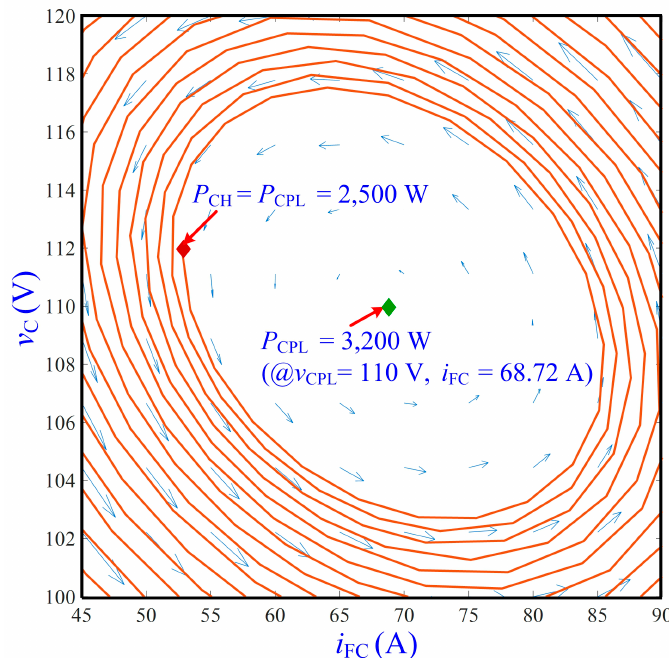
at a constant duty cycle d = 0.5767: ( a ) from 2250 W to 2500 W; ( b ) from 2500 W to 3200 W.